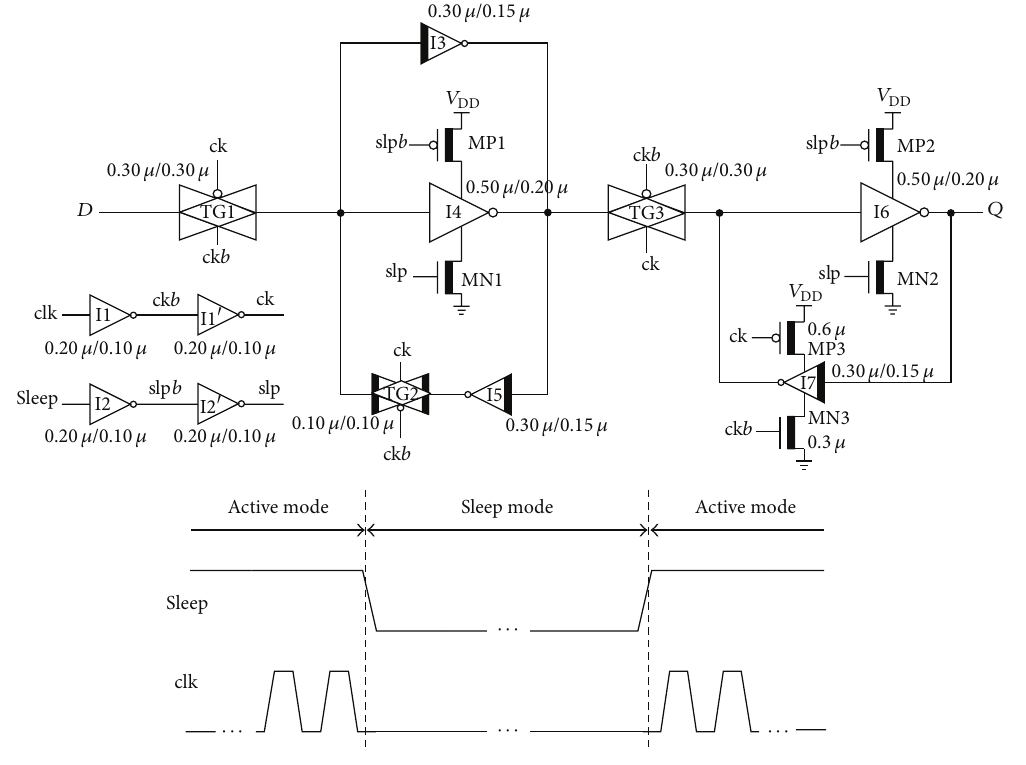
Figure 1: The Mutoh-FF circuits and its operation timing.